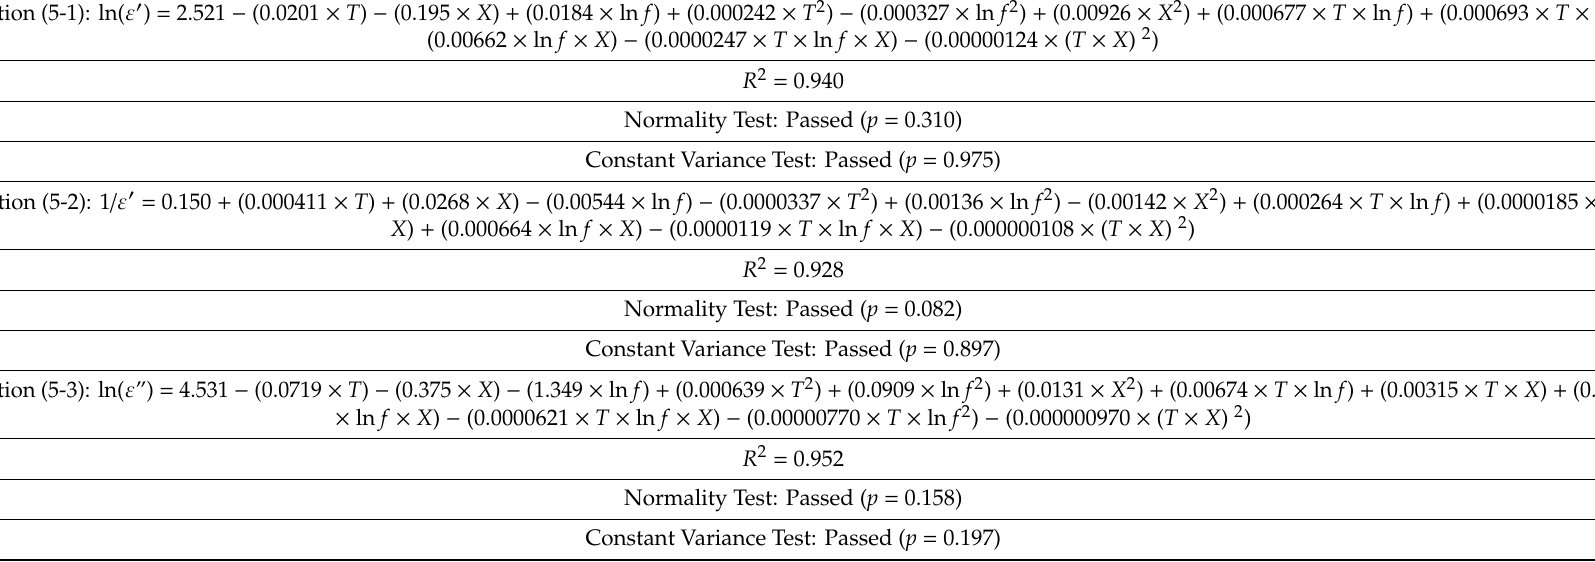
Table 5. The relationship between the dielectric properties and the influencing factors and statistical criteria established by regression analysis for black-eyed peas. Equation (5-1): ln( ε (cid:48) ) = 2.521 − (0.0201 × T ) − (0.195 × X ) + (0.0184 × ln f ) + (0.000242 × T 2 ) − (0.000327 × ln f 2 ) + (0.00926 × X 2 ) + (0.000677 × T × ln f ) + (0.000693 × T × X )